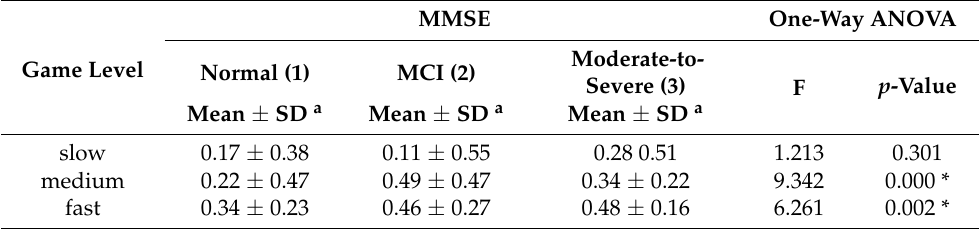
Table 11. Response times of subjects at different game level(s) (time-unlimited). MMSE One-Way ANOVA Moderate-to- Game Level Normal (1) MCI (2) Severe (3) F p